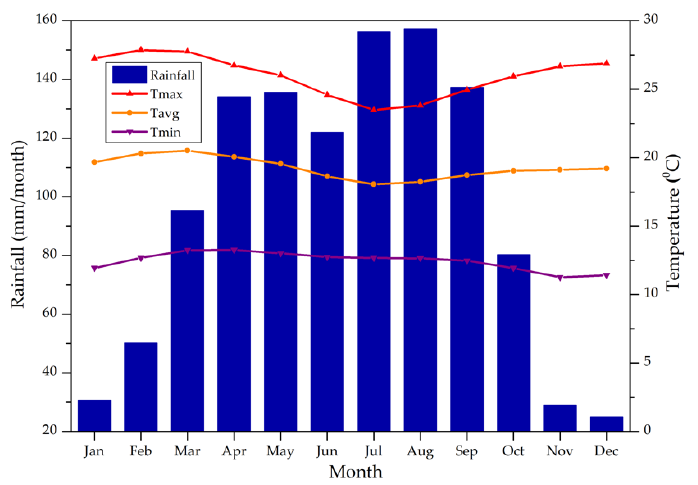
Figure 2. Monthly mean rainfall and temperatures (minimum, average, and maximum) for the period 1986–2015.